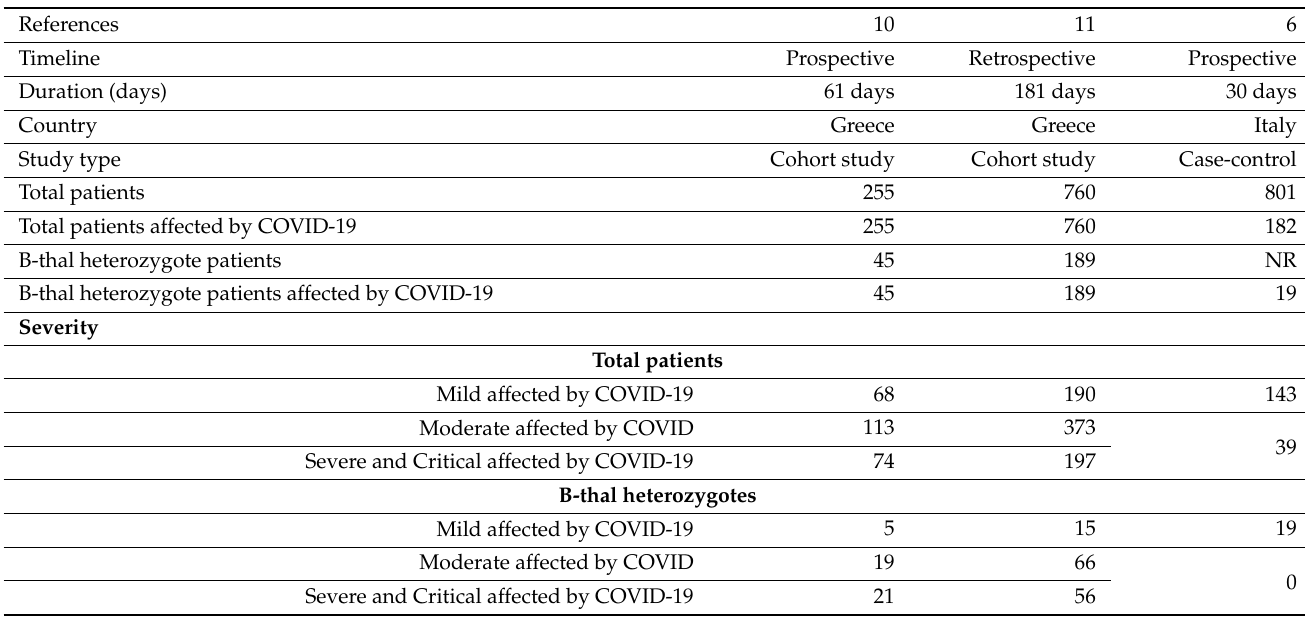
Table 1. Main characteristics of the included